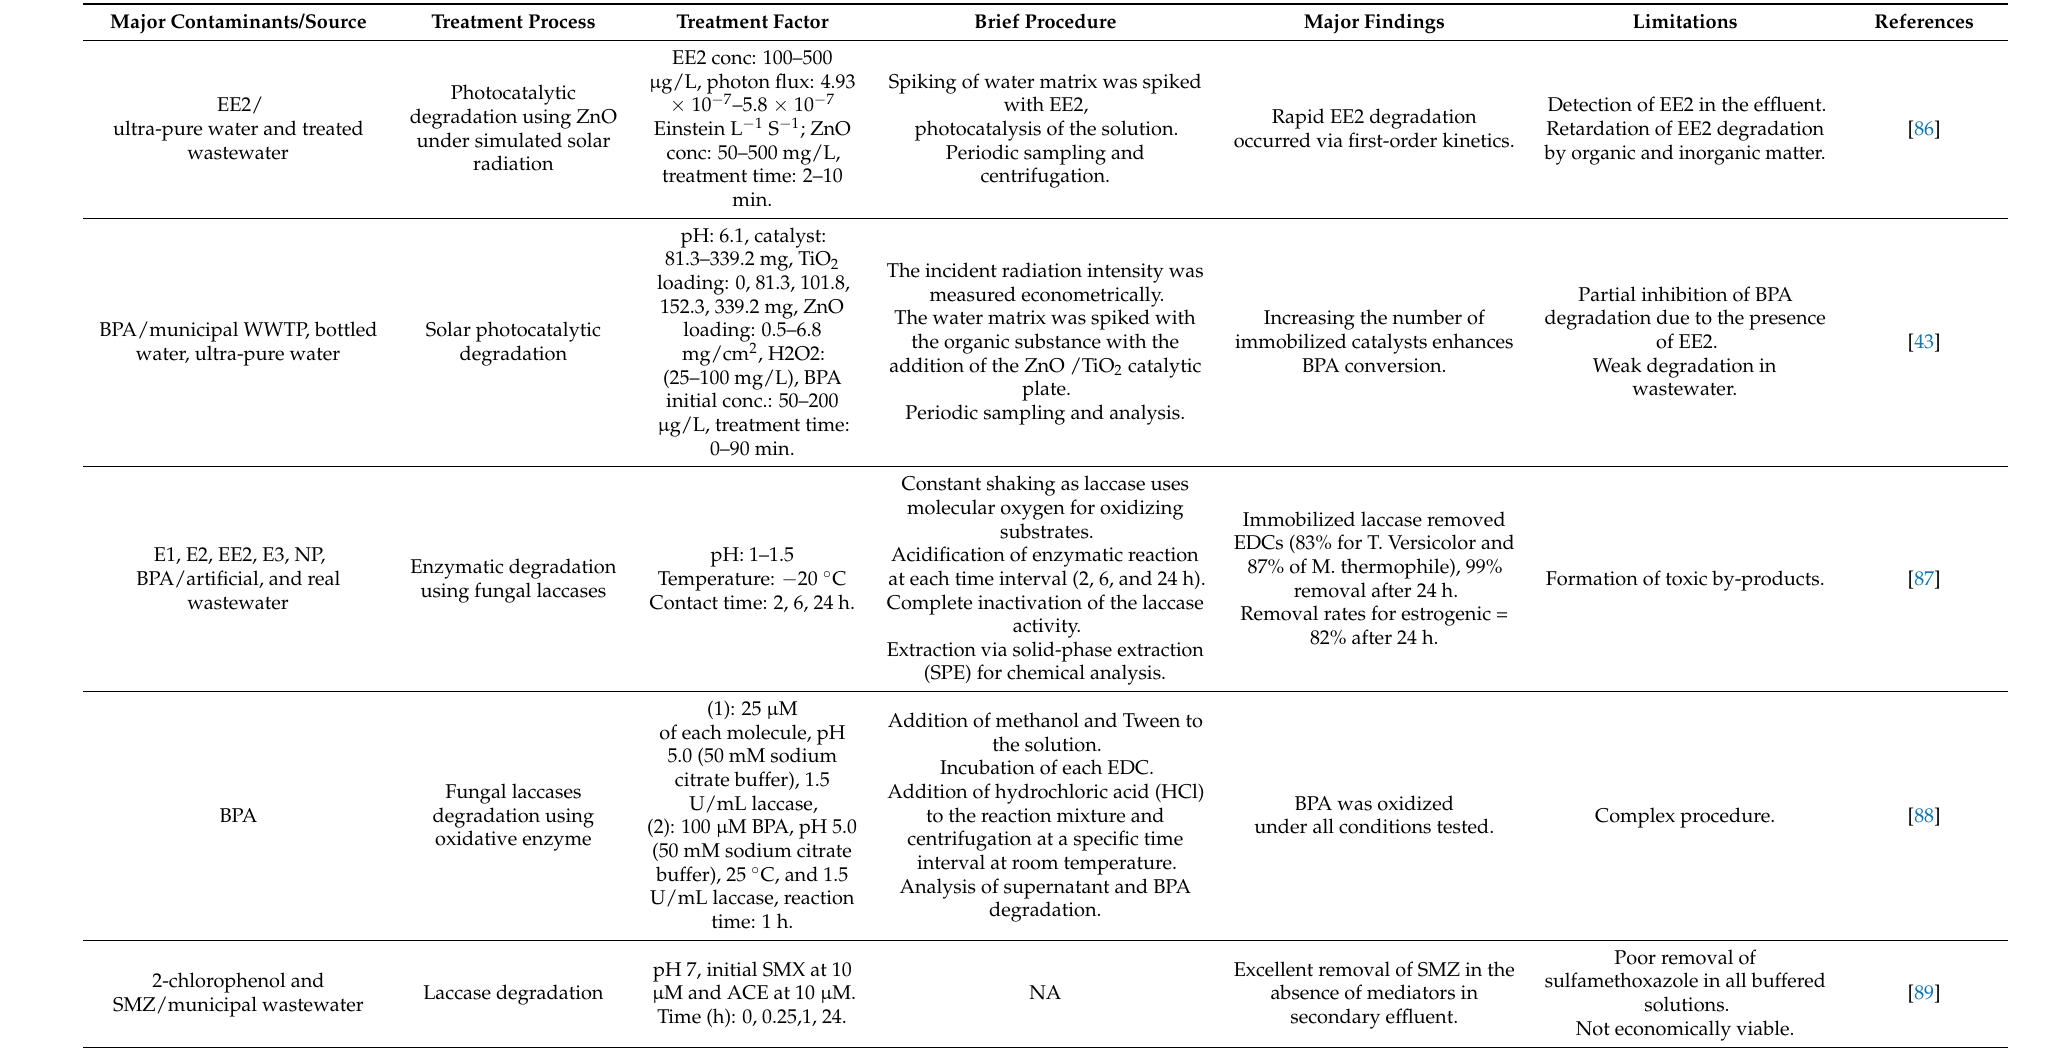
Table 3. Removals of some EDCs during photocatalytic and enzymatic degradation